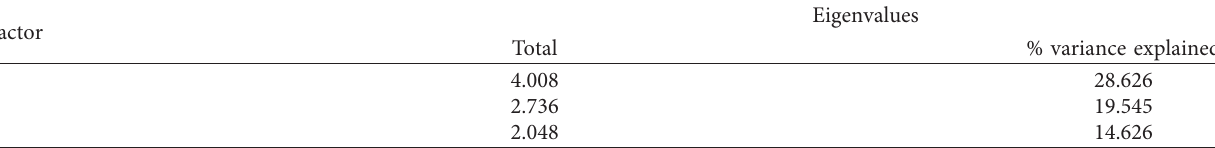
Table 3: Results of the EFA after rotation.